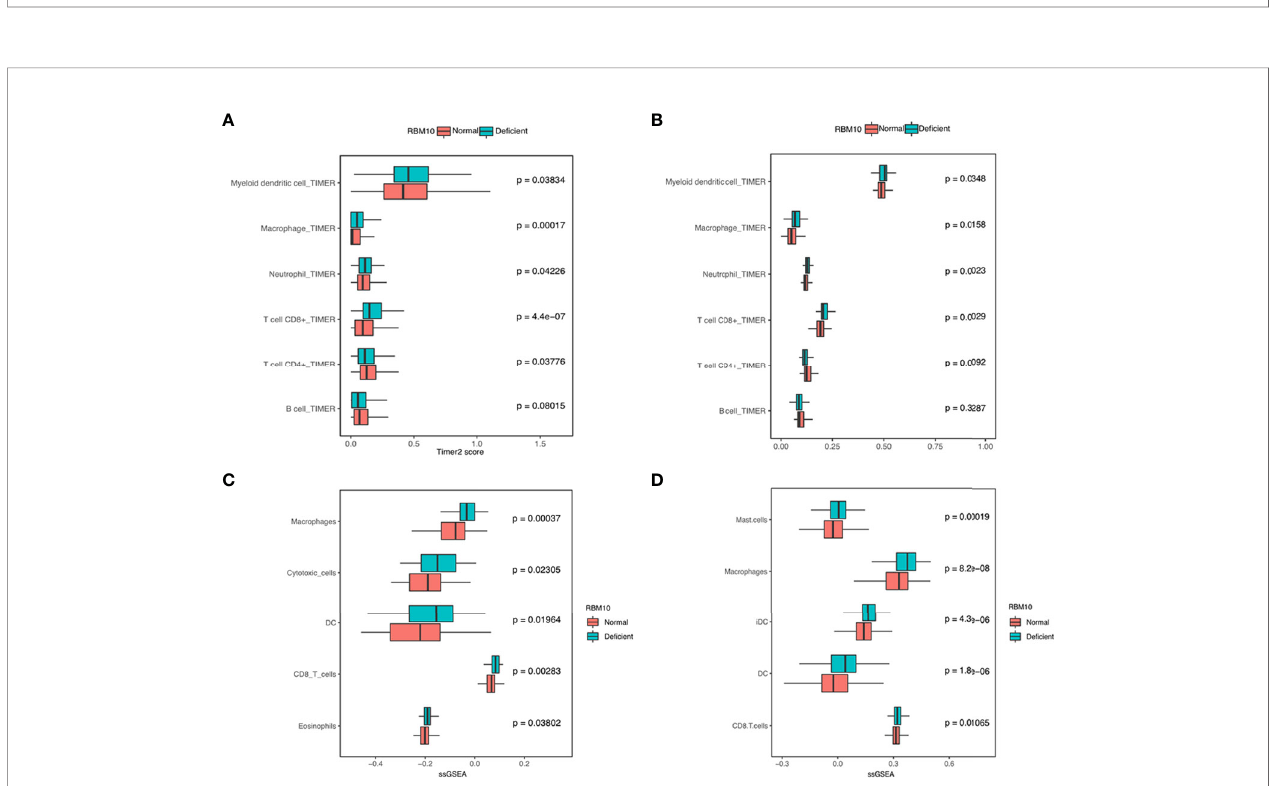
FIGURE 4 | LUADs with RBM10 de fi ciency show higher immune in fi ltration levels. (A, B) Immune in fi ltration levels estimated by TIMER are higher in RBM10 de fi cient LUADs in both TCGA_LUAD (A) and CHOICE_ADC (B) cohorts. (C, D) Diverse immune signatures estimated by ssGSEA also show higher enrichment levels in RBM10 de fi cient LUADs in TCGA_LUAD (C) and CHOICE_ADC (D) cohorts.